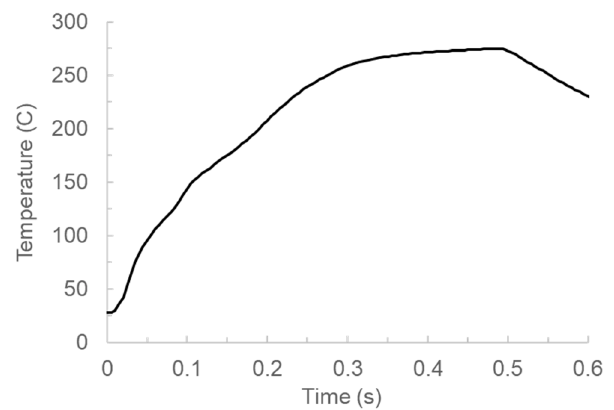
Figure 3. Temperature history at center of the joint interface measured in the Experimental Setup 1 condition as listed in Table 1. The measurement location is indicated by a small circle in the inserted temperature plots in Figure